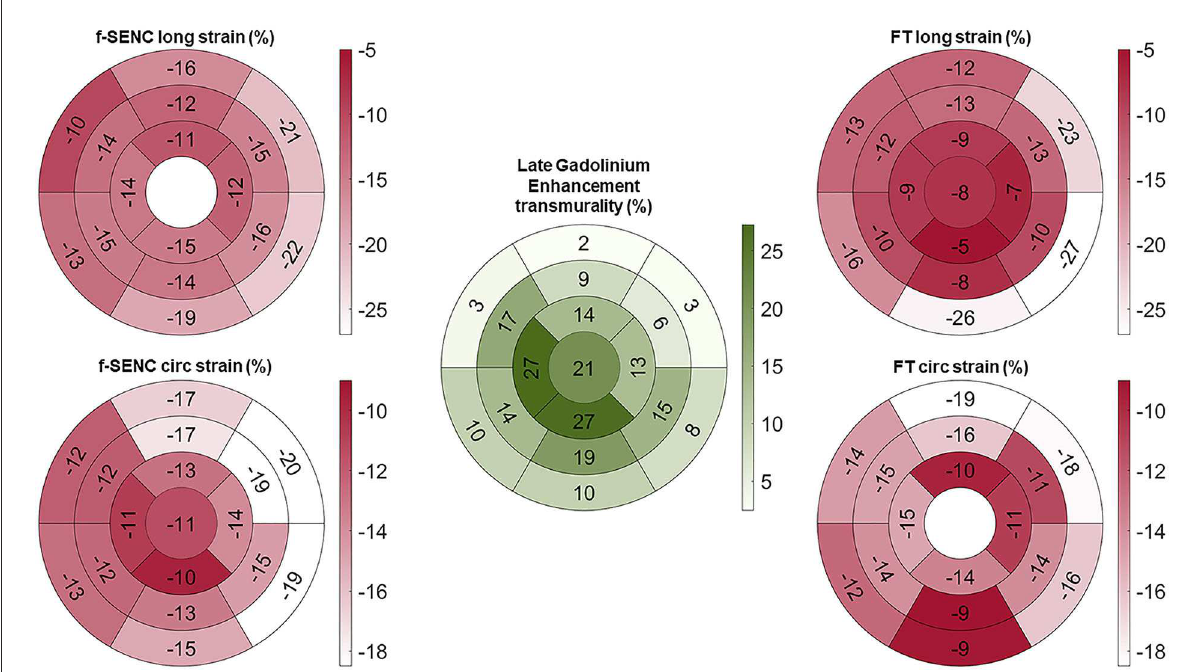
FIGURE3 Bull’s eye of mean longitudinal strain (long) and global circumferential strain (circ) of fast-SENC and FT with myocardial injury detected with late gadolinium enhancement